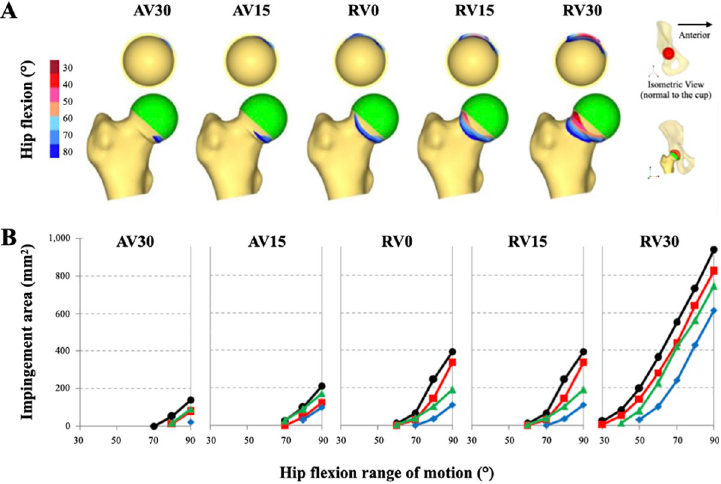
Fig 2. Impingement area at the anteroinferior femoral neck in relation to different femoral versions and degrees of hip flexion. (A) Schematic design showing the change in the impingement area with progressive femoral retroversion (this example accounts for an acetabular cup in 40˚ of inclination and 15˚ of version). (B) Impact of different acetabular cup positions on impingement area: 40˚ of inclination and 15˚ of version (black line); 40˚ of inclination and 25˚ of version (red line); 50˚ of inclination and 15˚ of version (green line); 50˚ of inclination and 25˚ of version (blue line).